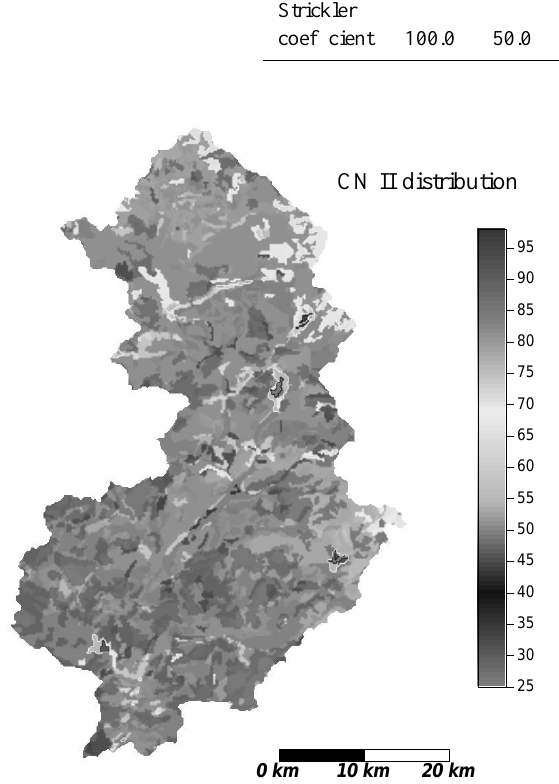
Figure 6. Spatial distribution of CN II for the Imera catchment. Figure 7. Spatial distribution of roughness coefficient k